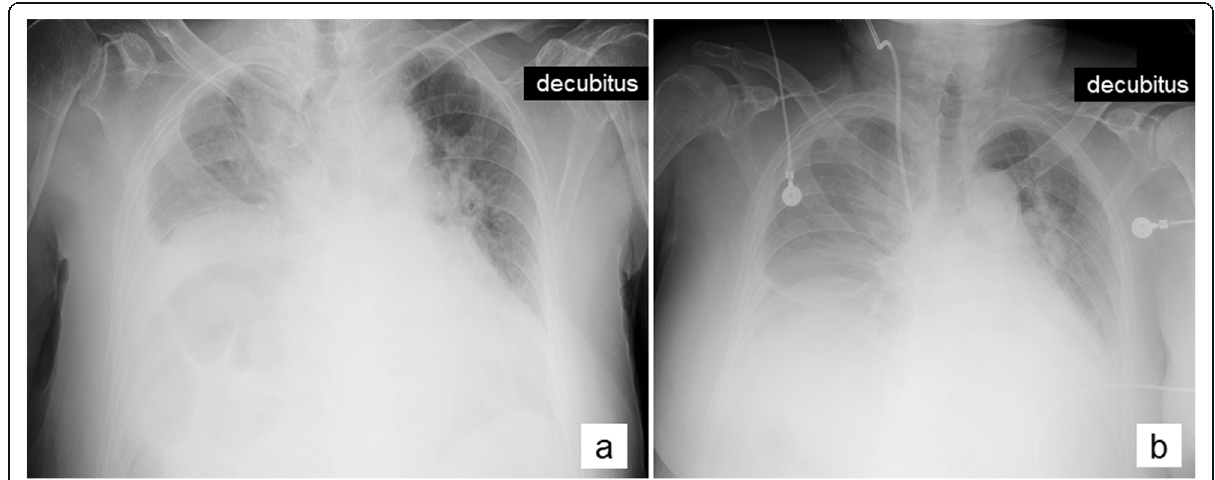
Fig. 1 Chest radiographs a before surgery and b after extubation. a Elevation of the right hemidiaphragm, right-sided pleural effusion, and dilated bowel were shown. b An increase in the right lung volume was